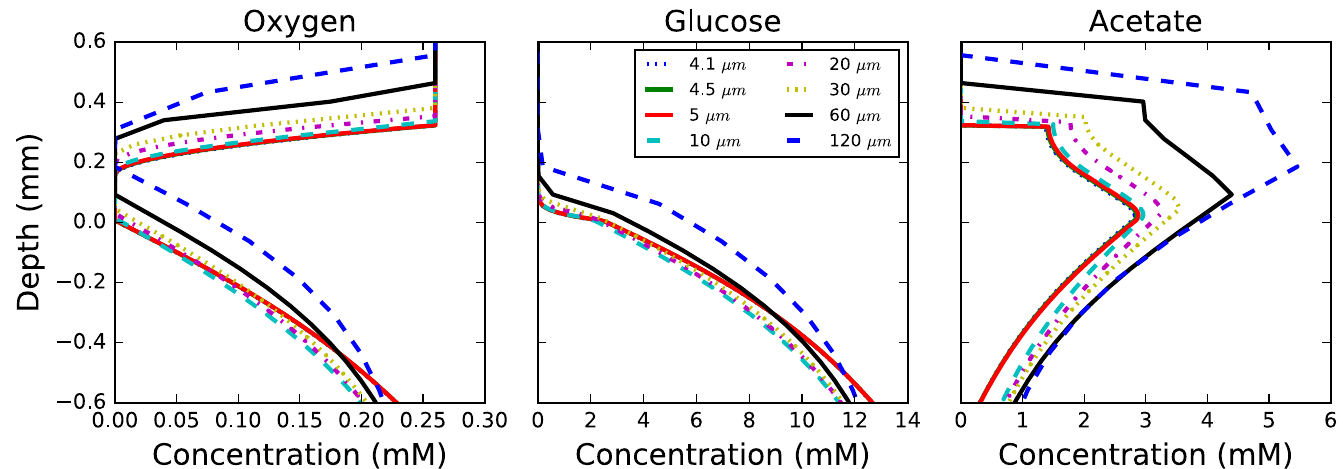
Fig 3. Species profiles. Profiles through the center axis of an E. coli K-12 MG1655 colony showingthe concentrations (x-axis) of severalmetabolites at a given depth (y-axis) relative to the agar surface after 30 hours of colony growth. Simulations demonstrate that concentrations predictedby 3DdFBA have a strong dependenceon the grid resolution.Concentration profilesare essentiallyconvergedafter 10 μ m; the deviationbelowa depth of about − 0.2 mm seen for higherresolutions(4.1 to 5 μ m) is due to boundary conditioneffects as a thinner agar layer was neededto allow for the simulationto fit in GPU